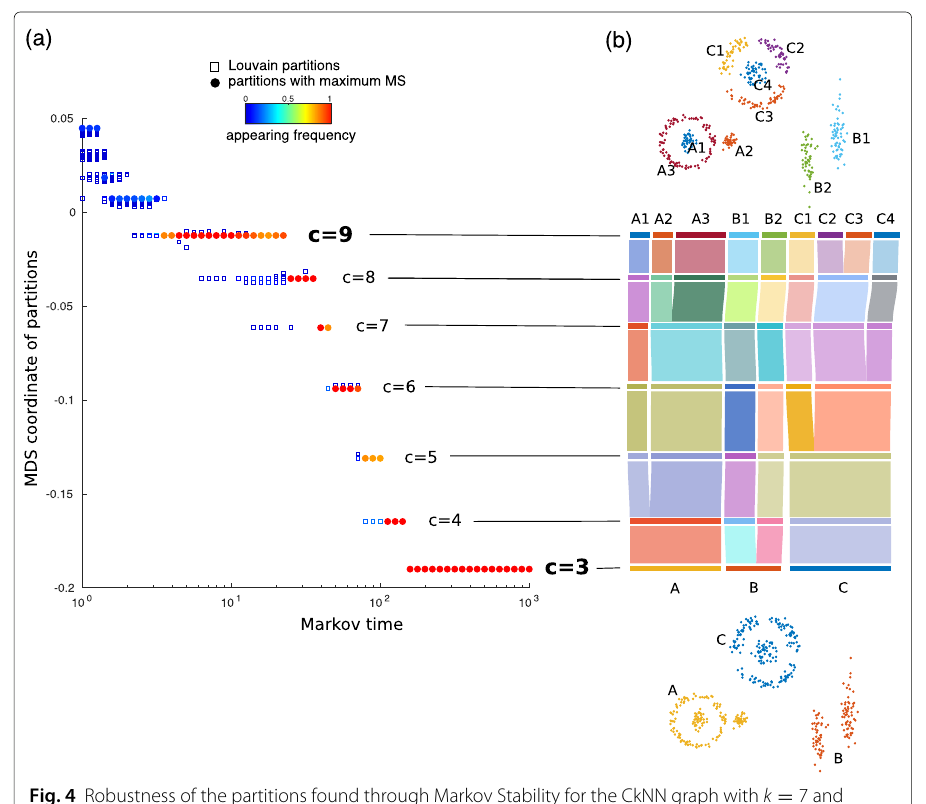
Fig. 4 Robustness of the partitions found through Markov Stability for the CkNN graph with k = 7 and δ = 1.8 of the dataset in Fig. 3. a We show the one-dimensional MDS embedding (based on the VI distance) of all the graph partitions found by the n L Louvain optimisations for each of the n T Markov times. The partition with the maximal Markov Stability at each Markov time is labelled by a filled circle, whereas the non-optimal partitions are represented by open squares. The graph partitions are coloured according to the frequency of their appearance in the optimisations. b The Sankey diagram represents the relationship between the partitions found by MS across Markov time, from c = 9 to c = 3. Note the hierarchical